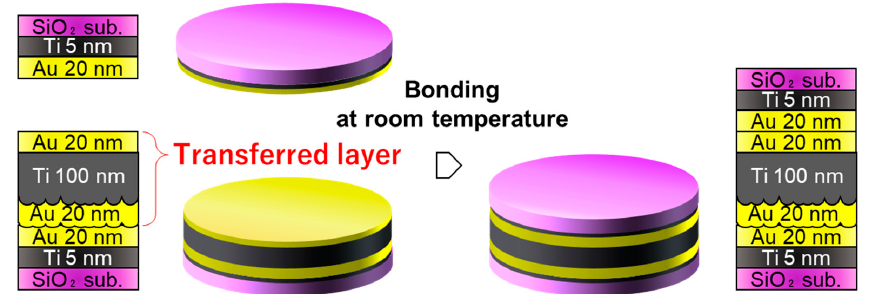
Figure 8. Room temperature bonding of transferred getter layer. They were bonded in a vacuum after Ar plasma irradiation.